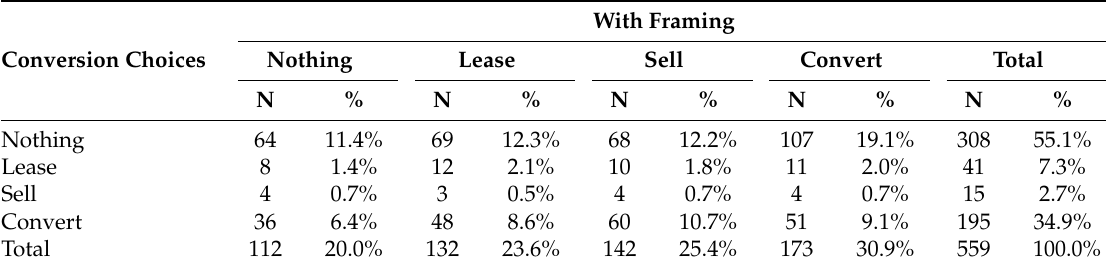
Table 6. Field behavior contrasts with choices in unframed risk game. With